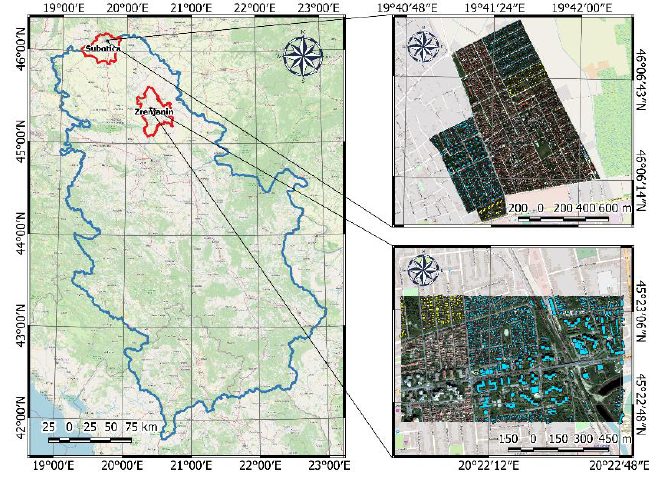
Figure 1. Area of interest.